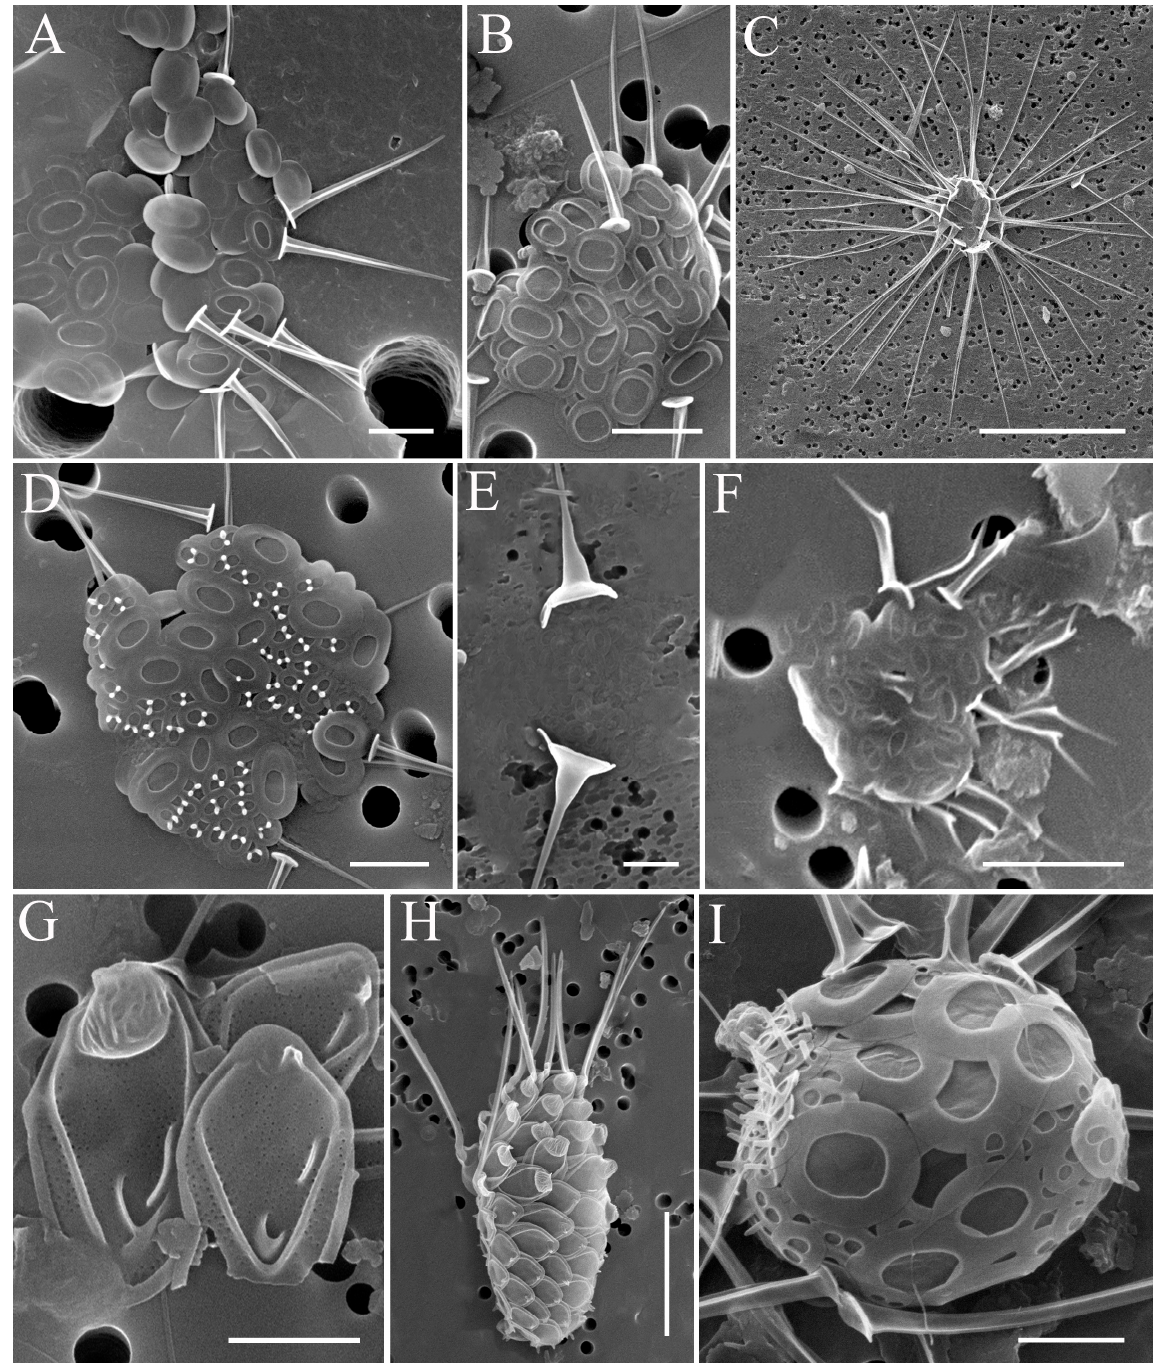
Figure 3. Silica-scaled chrysophytes from lakes Labynkyr and Vorota. SEM: ( A ) Spiniferomonas trioralis with oval plate scales; ( B ) Spiniferomonas sf. trioralis with oval and rounded plate scales; ( C ) S. trioralis f. cuspidata ; ( D ) S. cornuta ; ( E ) S. conica ; ( F ) S. takahashii ; ( G , H ) Mallomonas sp. 1; ( I ) S. serrata . Scale bars: ( A , B , D – G , I ) 2 μ m; ( H ) 10 μ m; ( C ) 15 μ m.